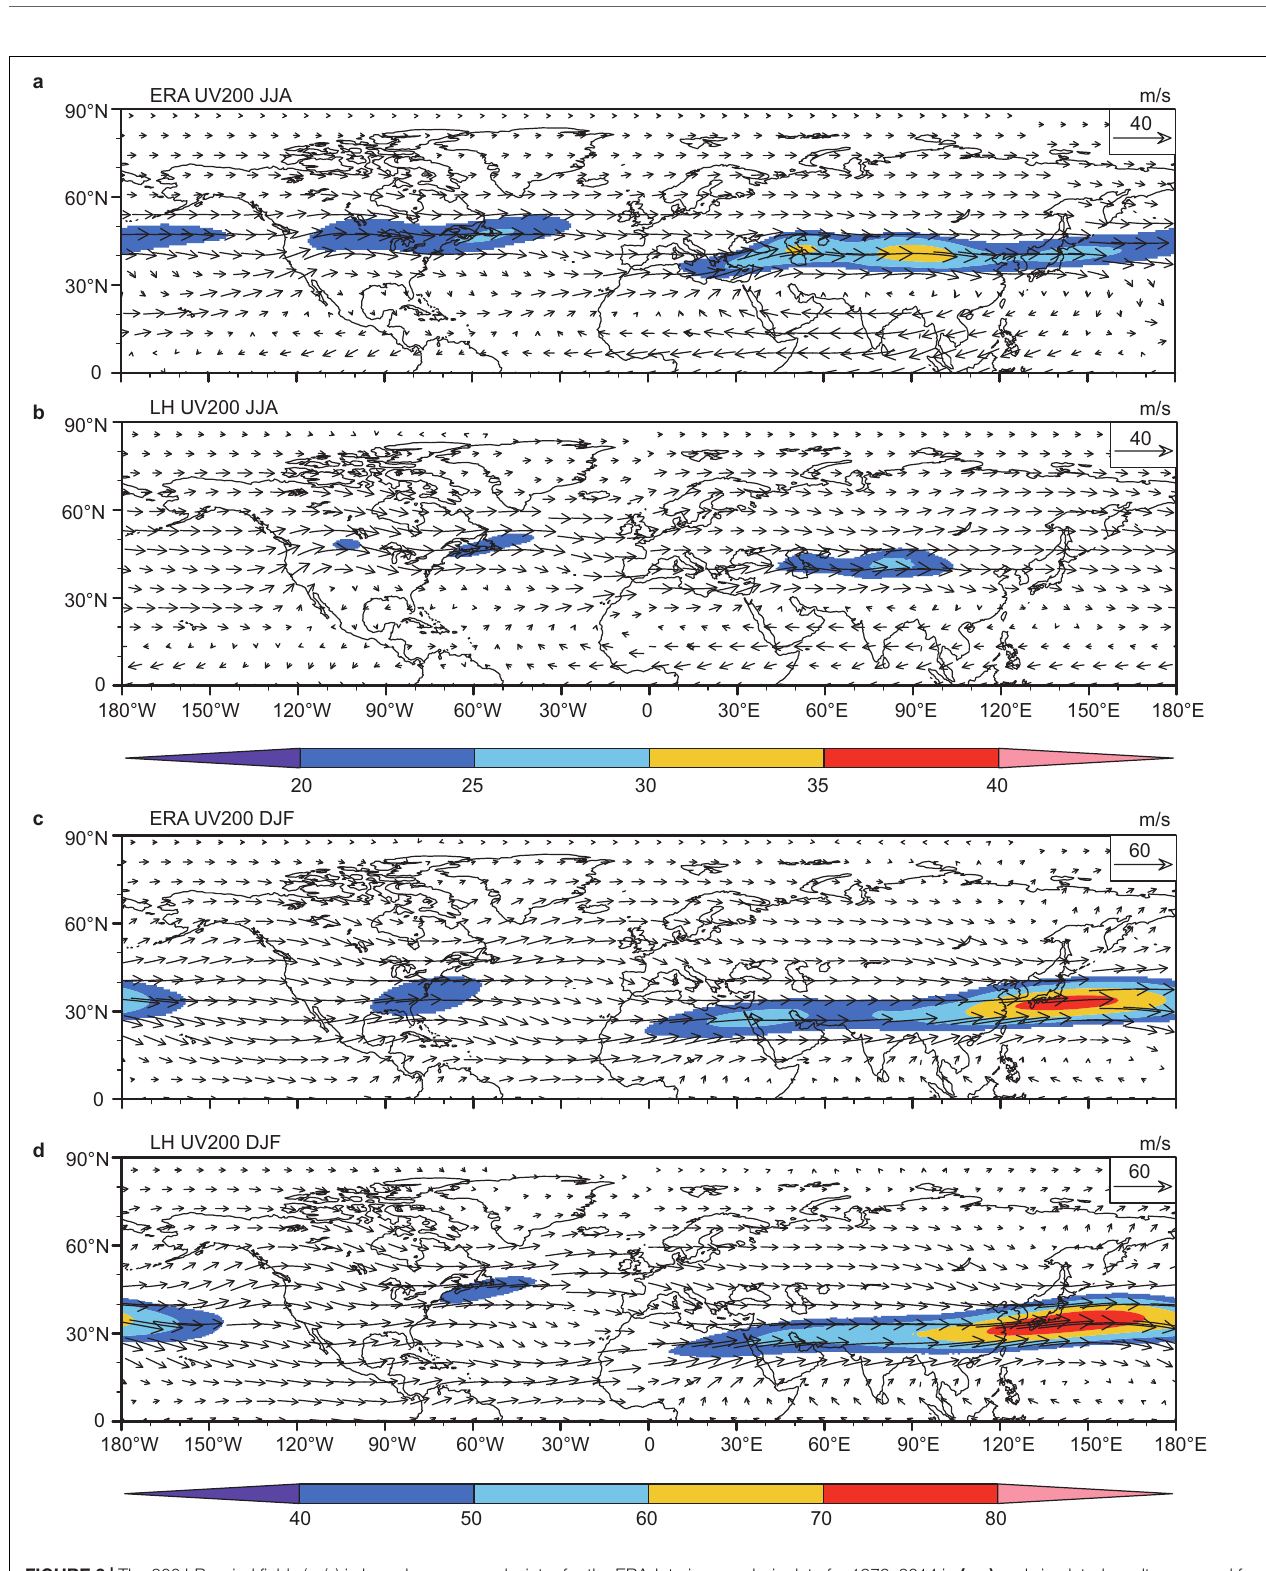
FIGURE 2 | The 200 hPa wind fields (m/s) in boreal summer and winter for the ERA-Interim reanalysis data for 1979–2014 in (a,c) and simulated results averaged for 1-0 ka BP (b,d) . Vectors are the 200 hPa horizontal winds (m/s) and the shading represents the jets with wind speeds more than 20 m/s in summer and 40 m/s in winter,